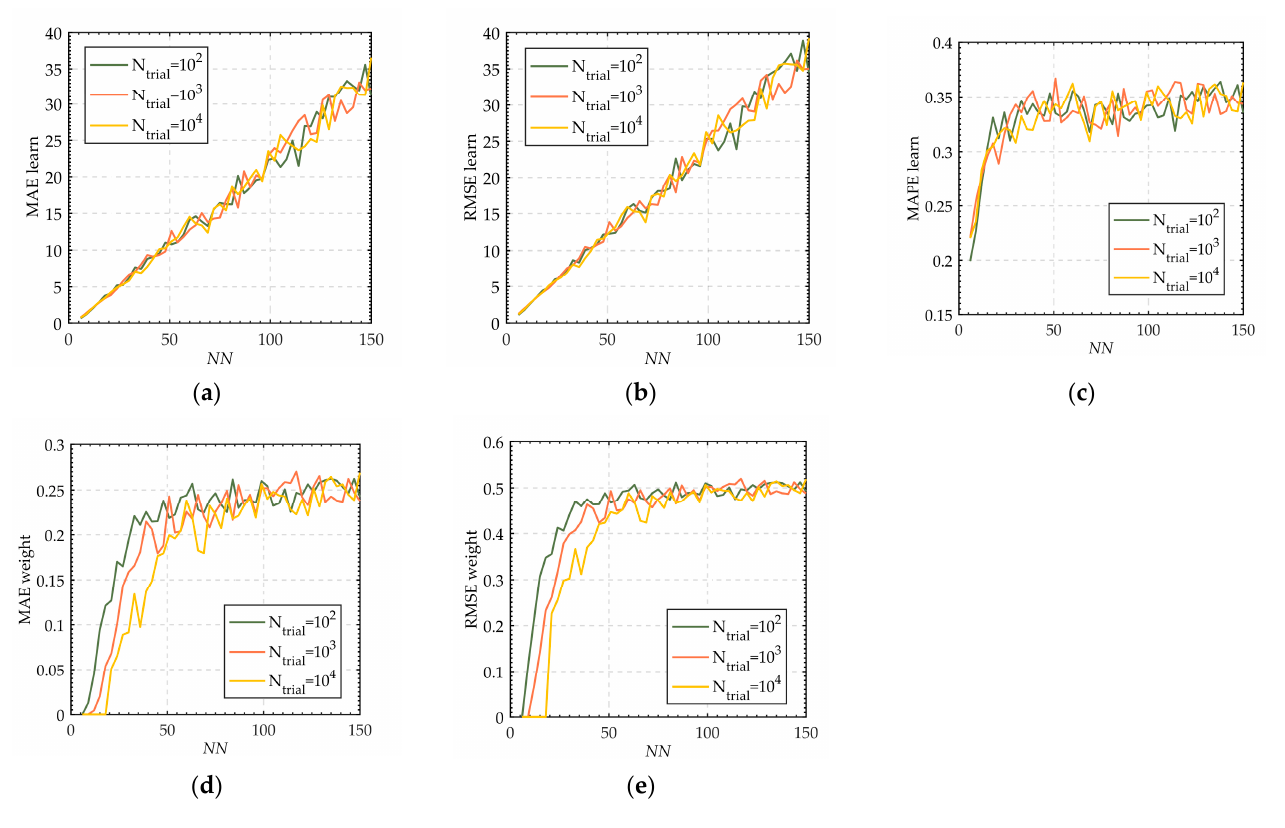
Figure 9. Error performance for ( a ) MAE learn , ( b ) RMSE learn , ( c ) MAPE learn , ( d ) MAE weight , and . ( e ) RMSE weight